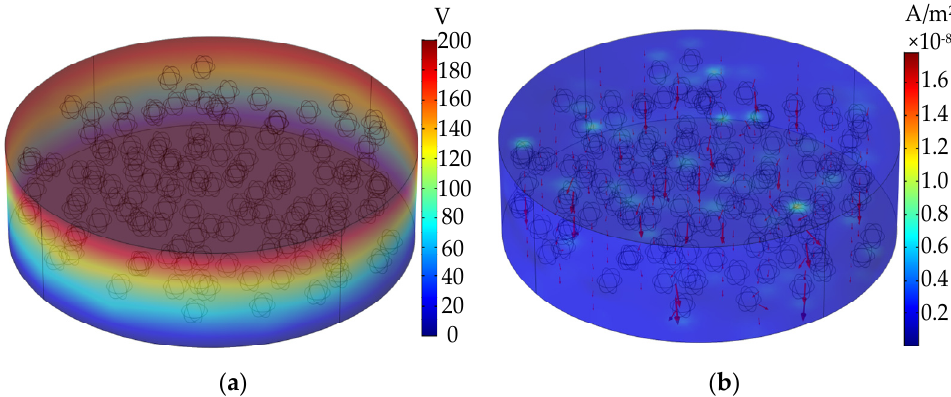
Figure 5. Potential and current density distribution diagram. ( a ) Potential distribution; ( b ) current